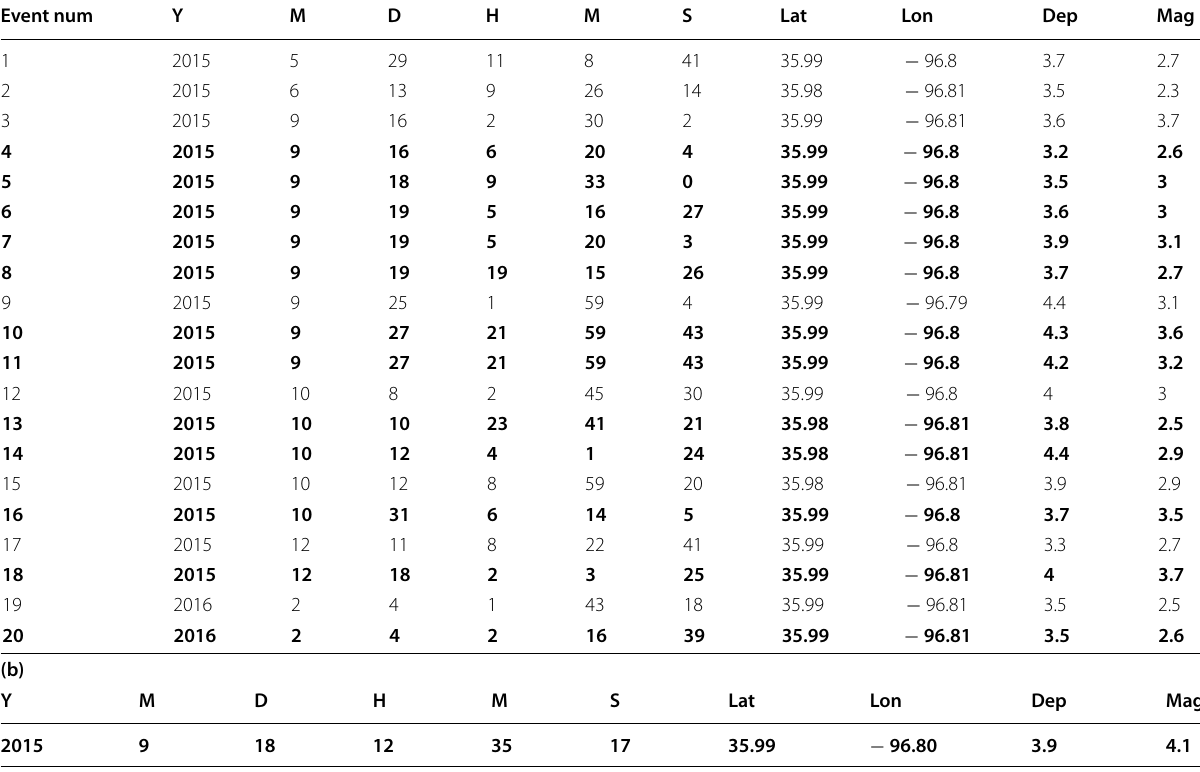
Table 1 (a) Event list in a cluster. Rows list year, month, day, hour, minute, second, latitude (degrees), longitude (degrees), depth (km), and magnitude. Event numbers with thin characters indicate an event not selected. (b) Event information of a large